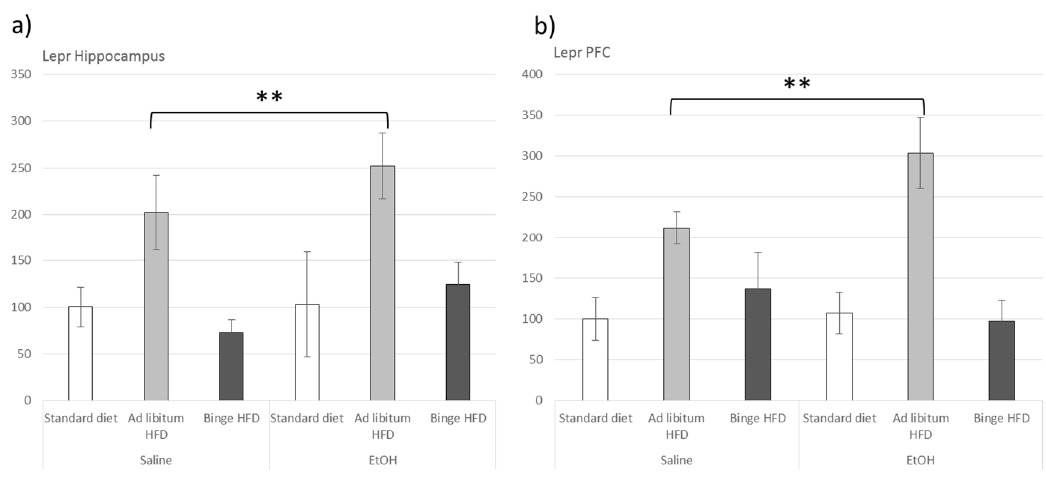
Figure 4. Effect of an ad libitum or binge HFD exposure and EtOH binge on adolescent mice in the leptin receptor expression in the hippocampus ( a ) and the prefrontal cortex (PFC) ( b ). Data are presented as mean ( ± SEM), ** p < 0.01, versus EtOH counterparts.